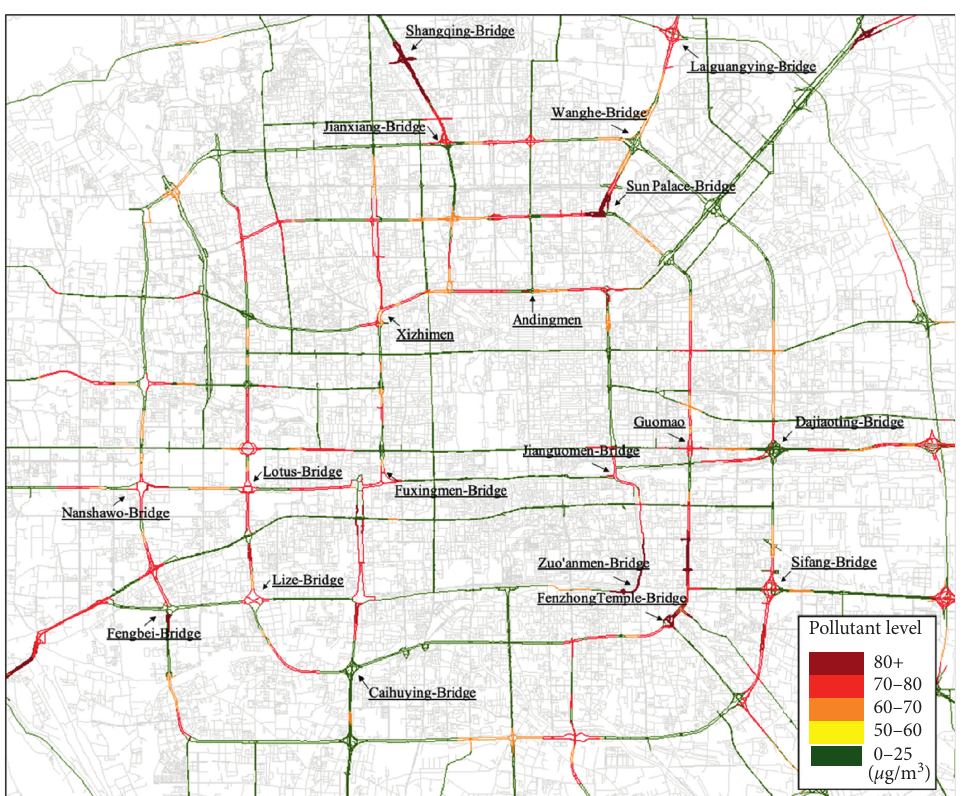
Figure 19: PM 2.5 concentration of the urban road network at 7am in August.